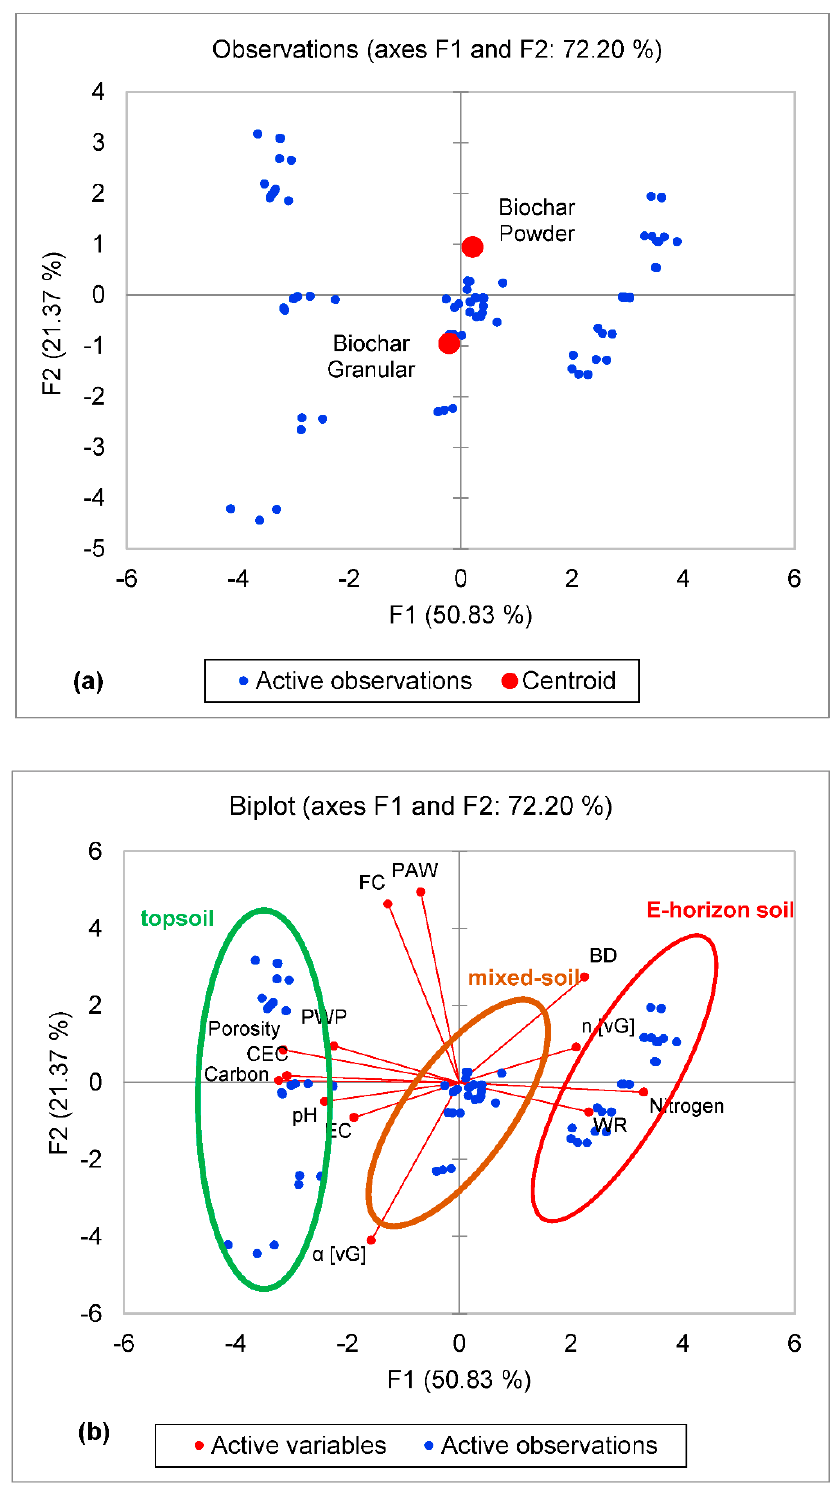
Figure 11. Principal component analysis (PCA) output of ( a ) observation and ( b ) biplot showing the effects of biochar on physicochemical parameters of podzolic soil.